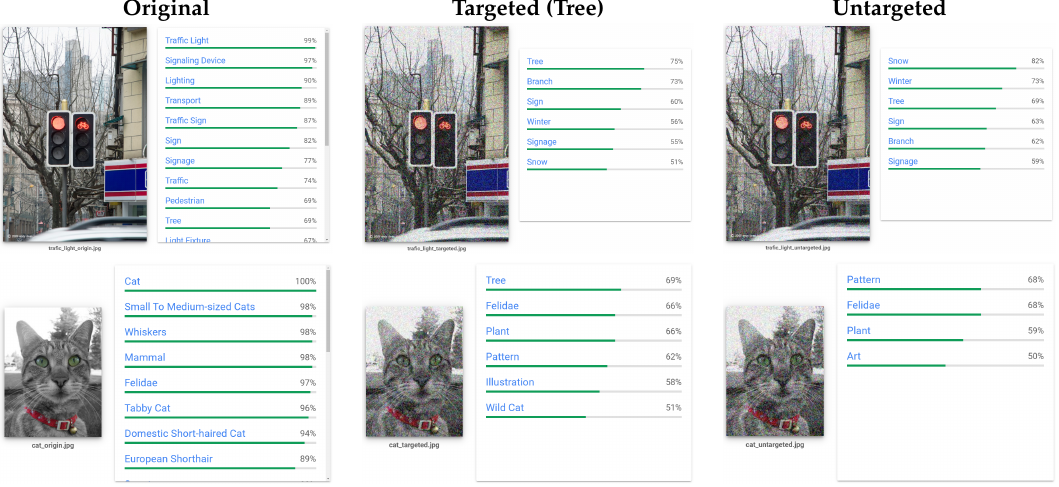
Figure 7. Our adversarial examples on Google Cloud